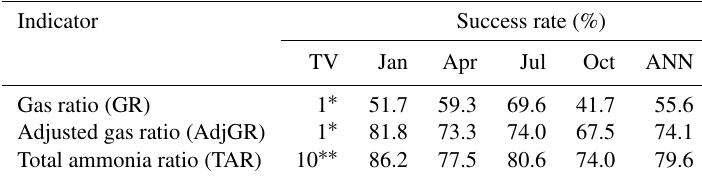
Table 3. Summary of observable indicators and their performances in predicting PM 2 . 5 chemistry.